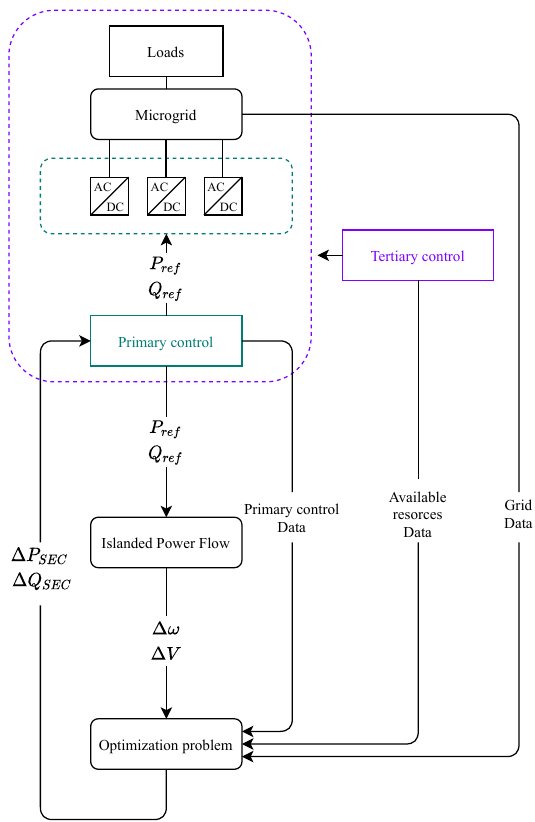
Figure 4. Hierarchical control